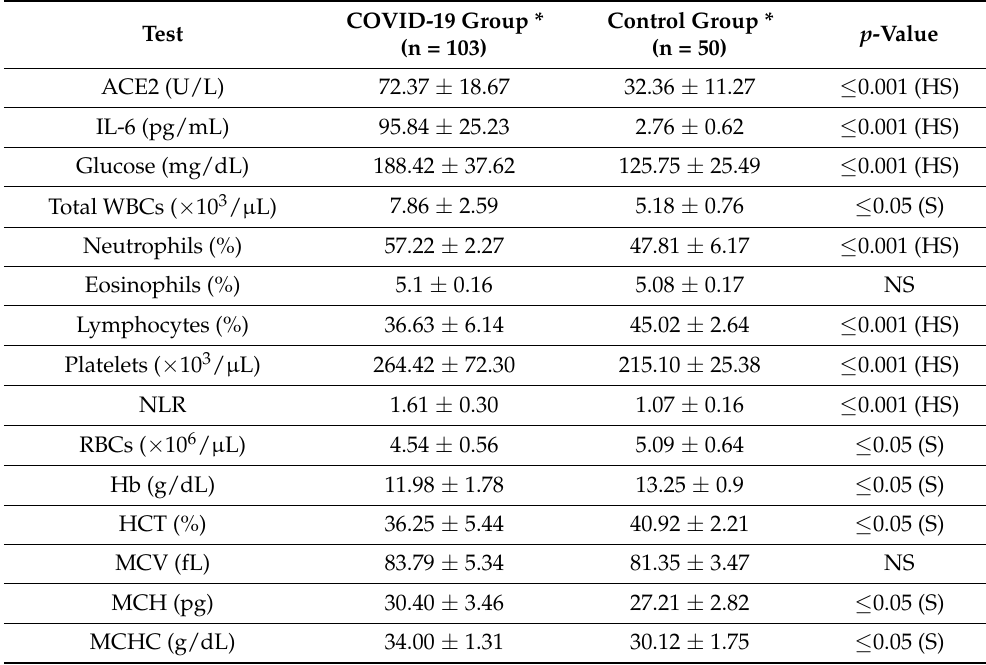
Table 2. Laboratory test results for COVID-19 positive group compared with the control group.